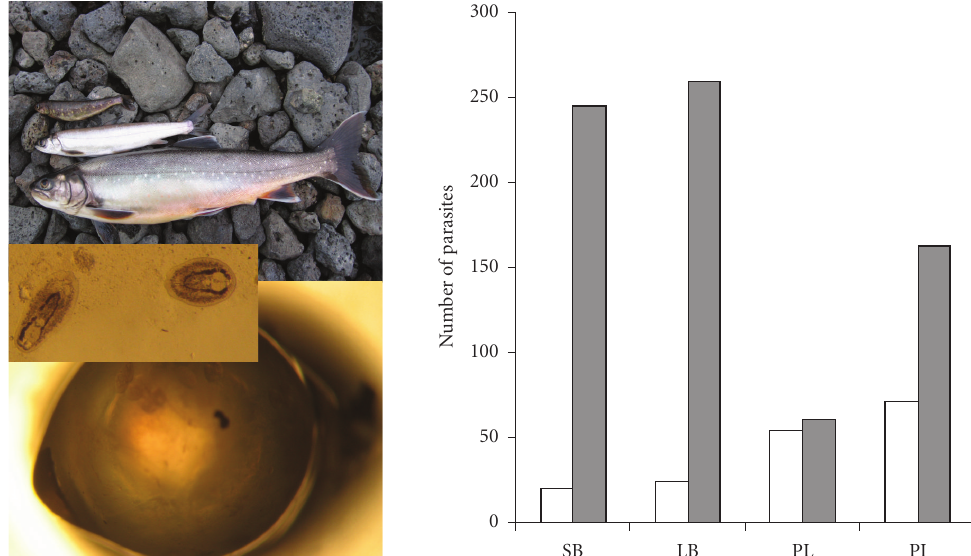
Figure 1: Top left: three of the four ecotypes and species of Arctic charr ( Salvelinus alpinus species complex) found in Thingvallavatn, Iceland (top left). S. thingvallensis , a small benthic ecotype (uppermost) lives mainly in lava crevices, the pelagic ecotype, one morph of S. murta (middle) feeds mainly on plankton in open water, and the large piscivore ecotype, another morph of S. murta (lowermost) preys upon smaller fishes. Bottom left: Diplostomum metacercariae in an eye lens of fish (all photos Anssi Karvonen). These widespread and abundant parasites cause cataracts and have significant fitness consequences for the fish. Species of the same genus are also found in the vitreous humour of the fish eye, like in the Icelandic ecotypes of charr. Right: average total sum of cestodes (white bars) and trematodes (grey bars) in the four ecotypes of arctic charr in Thingvallavatn (SB: small benthic S. thingvallensis , LB: large benthic S . sp., PL: planktivorous S. murta , PI: piscivorous S. murta ). The result illustrates the extent of variation in parasite infections between the sympatric and parapatric ecotypes and interactions between di ff erent parasite taxa. Figure produced with permission of John Wiley & Sons Inc. from data in Frandsen et al.